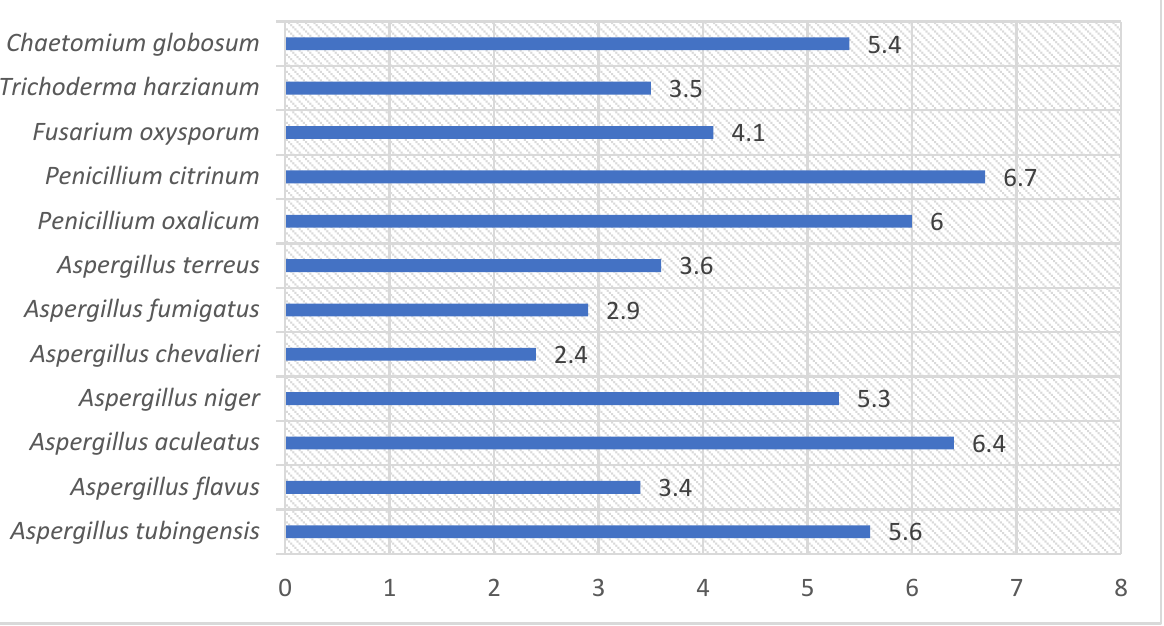
Figure 5. Phosphate solubilization ability (mm) of the fungal strains after 7 days of incubation.